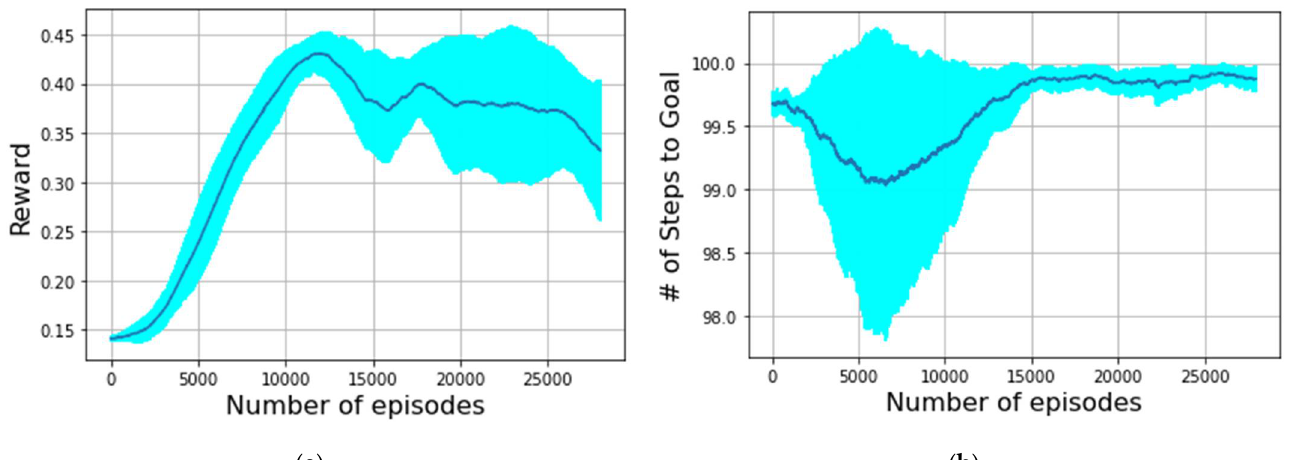
Figure 2. Learning curves for 2-qubit Bell state generation. Each data point is the moving average of 2000 episodes, and the average value (solid line) with one standard deviation error bar (cyan color) over 10 independent curves are reported. ( a ) Reward is plotted against number of episodes; ( b ) number of steps to reach the goal is plotted against number of episodes.